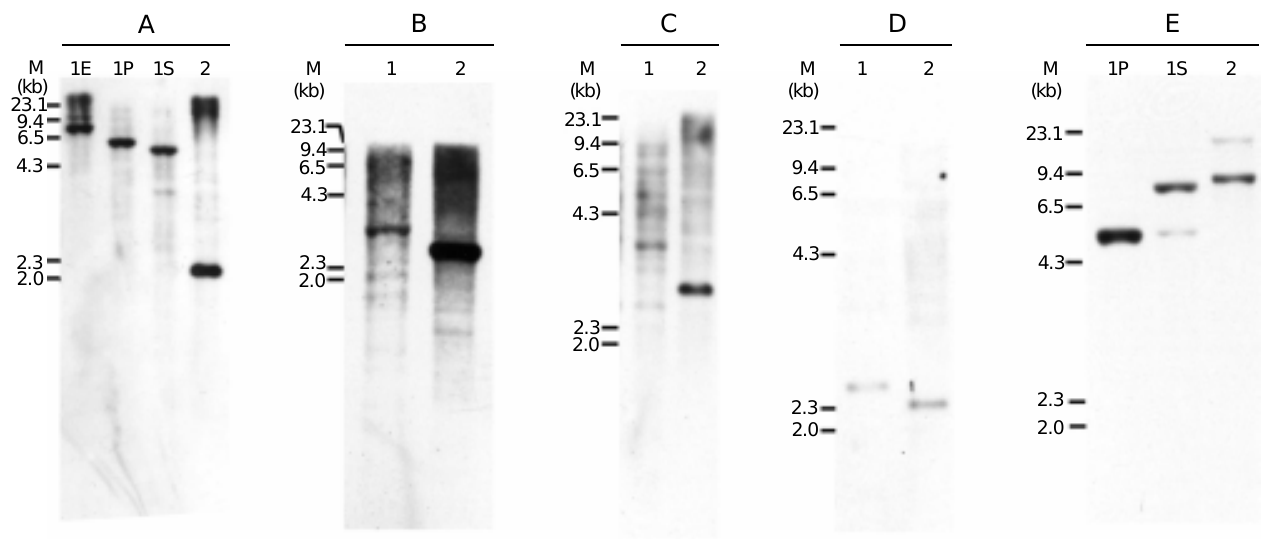
Figure 1. Hybridization pattern of Azospirillum amazonense total DNA with Eco RI (1E), Pst I (1P), and Sal I (1S) in A , Sal I in B , C and D , and Pst I (1P) and Sal I (1S) in E with the following probes: nifD in panel A; nifEN in panel B; fixABC in panel C; nifA in panel D, and glnB in panel E. Lane 2 represents A. brasilense total DNA digested with Pst I in A , C and E , or Sal I in B and D . Lane M contains